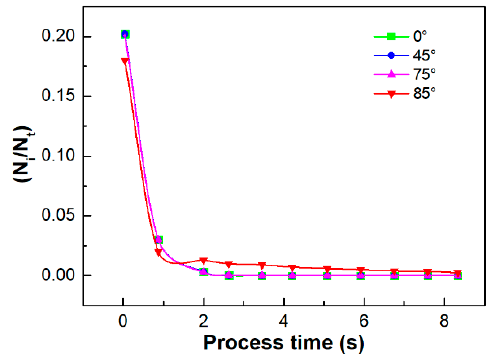
Figure 8. The curves of the ratio of the number of islands ( N i ) to the total number of atoms deposited at the same moment ( N t ) under various deposition angles at the initial growth stage.